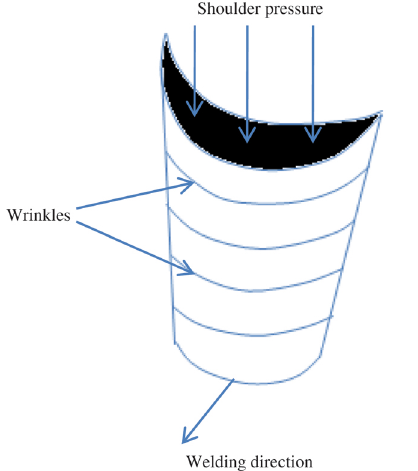
Figure 14: Extruded material in crescent